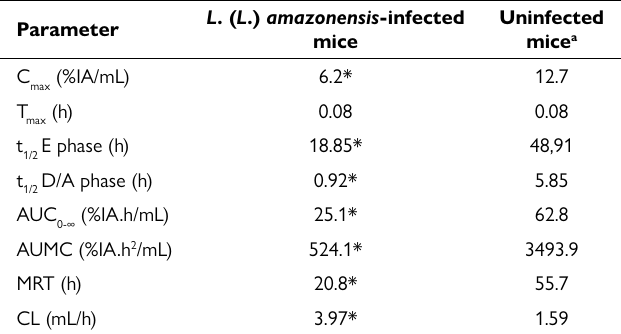
Table 1 Mean pharmacokinetic parameters in the blood of uninfected (n= 5/time) and L. ( L. ) amazonensis -infected BALB/c mice (n= 5/time) following intraperitoneal administration of meglumine antimoniate.